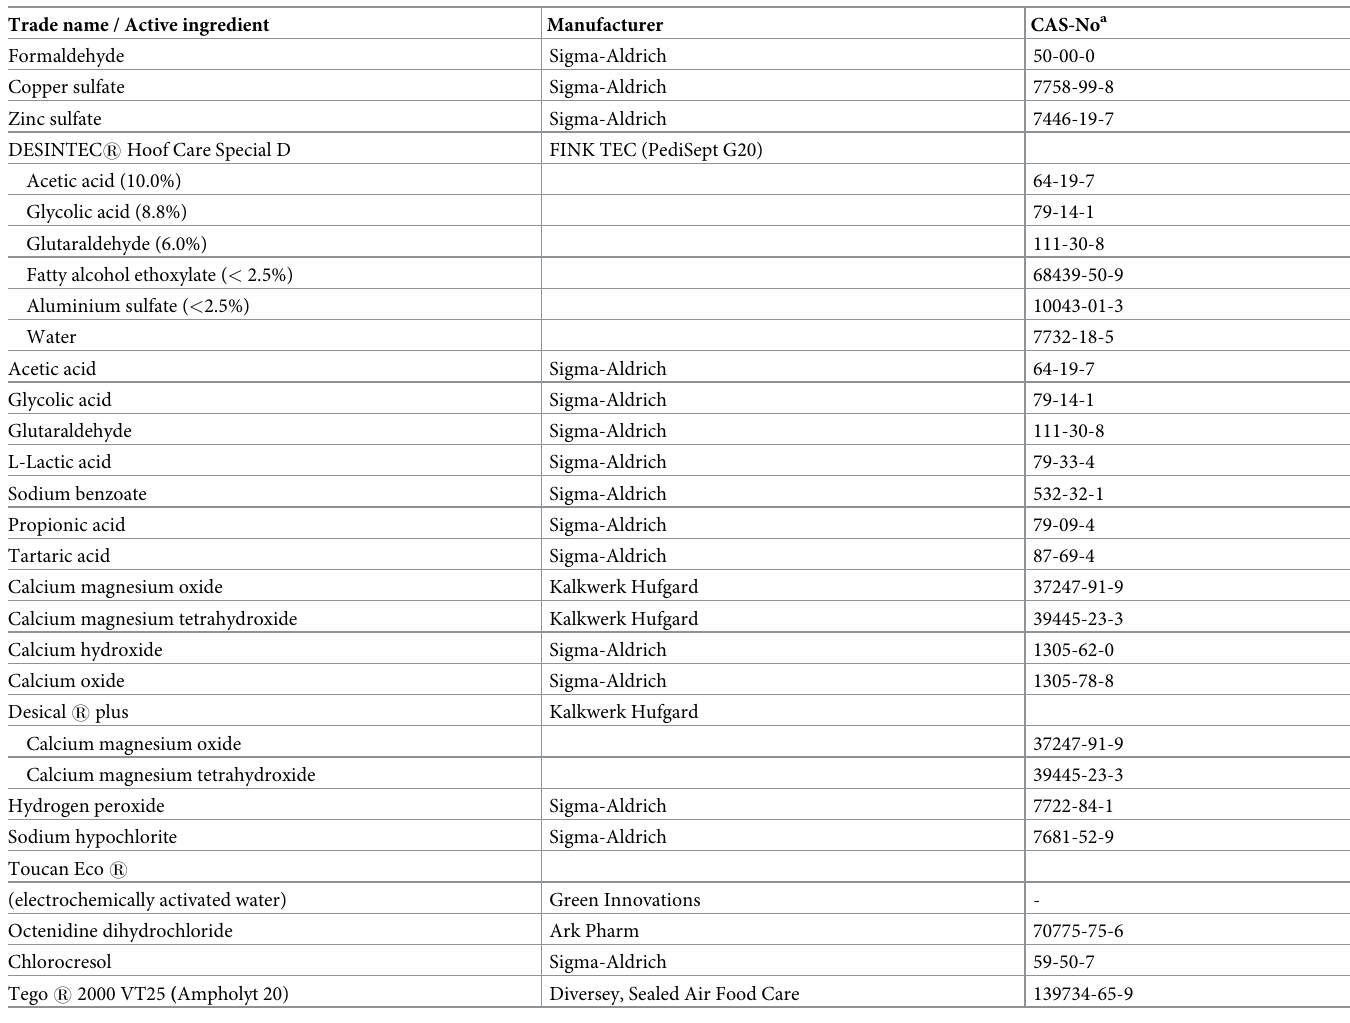
Table 1. Disinfectants